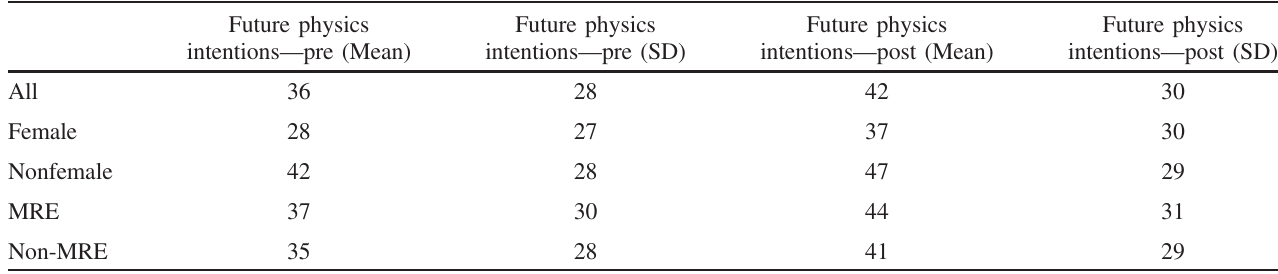
TABLE VIII. Summary of Study 1 measures, by demographic group. Percentages quoted represent pre- and post-future physics